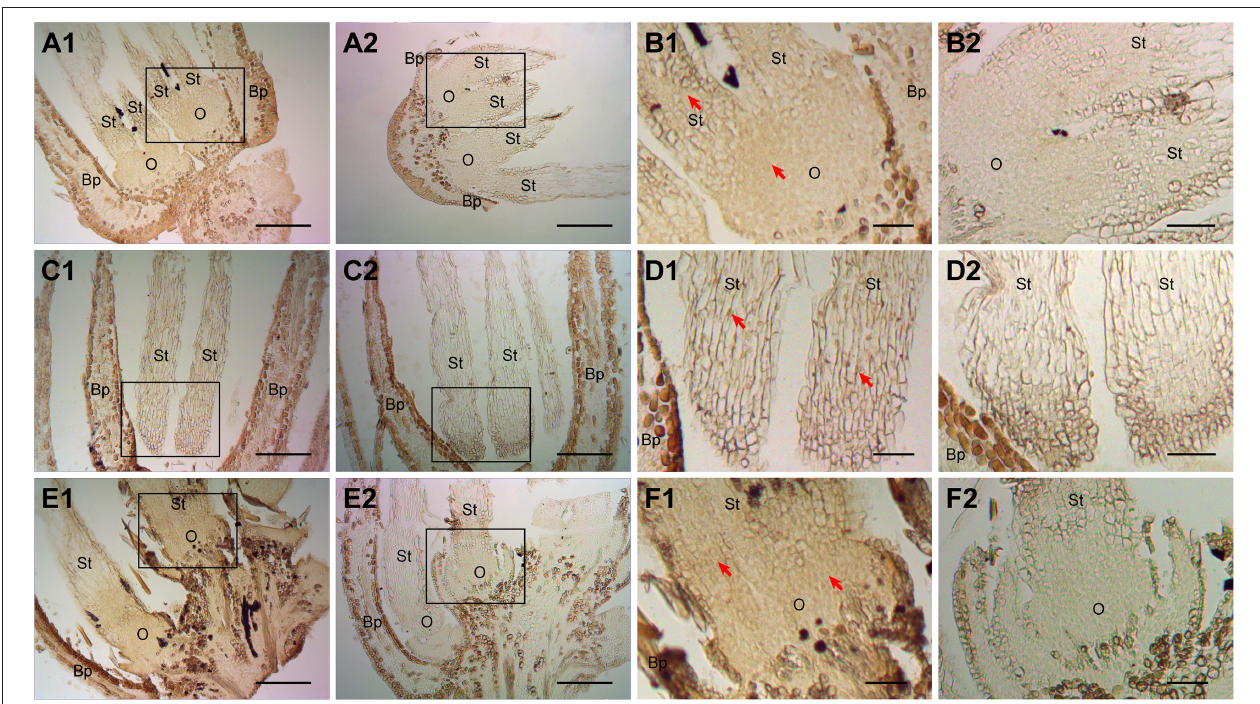
FIGURE 3 | Effects of IAA and TIBA on ChARF3 localization after pollination. (A1, C1, and E1) Female flowers treated with IAA, TIBA, or distilled water, respectively. (B1, D1, and F1) The enlarged views of black squares in A1, C1, and E1, respectively. (A2–F2) The control of A1 to F1 without secondary antibody treatment, respectively. Key: Bp, bract primordium; O, ovary; St, style. Scale bars: A, C, E = 200 µ m; B, D, F = 50 µ m. Positive staining is shown in brown. Red arrows indicate the localized